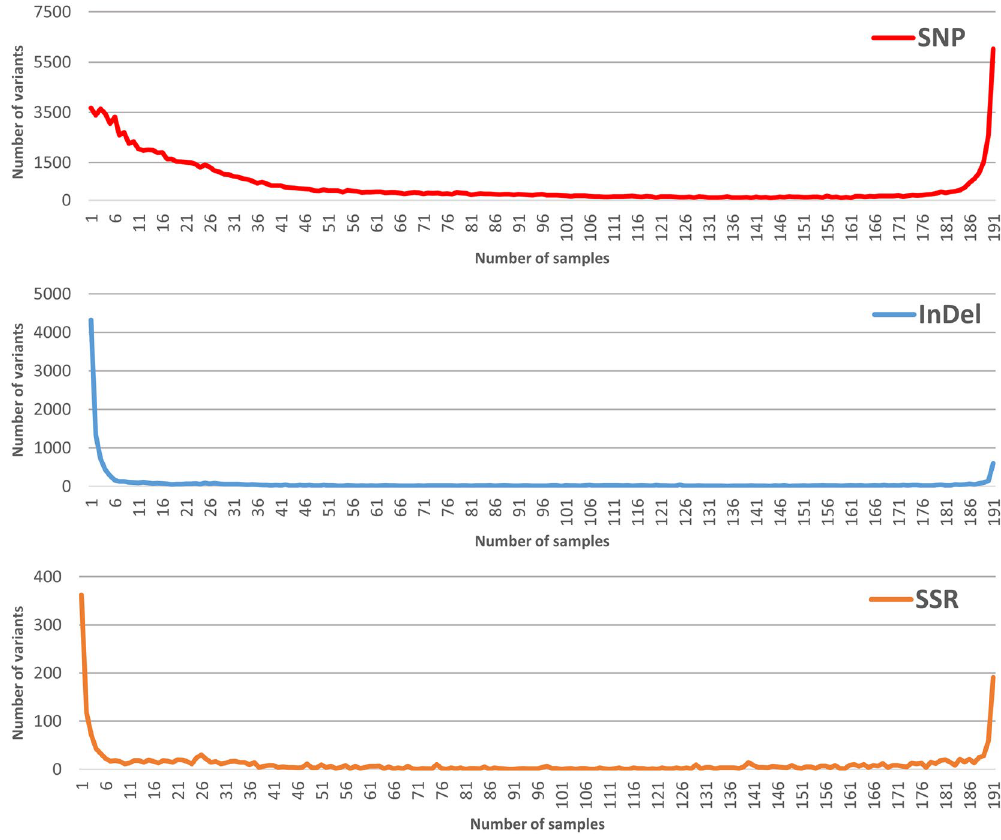
Figure 6. Distribution of the number of variant identified in group of samples. For each kind of variant identified (SNP, InDel and SSR), the number of variants genotyped in 1 to 191 peach samples are